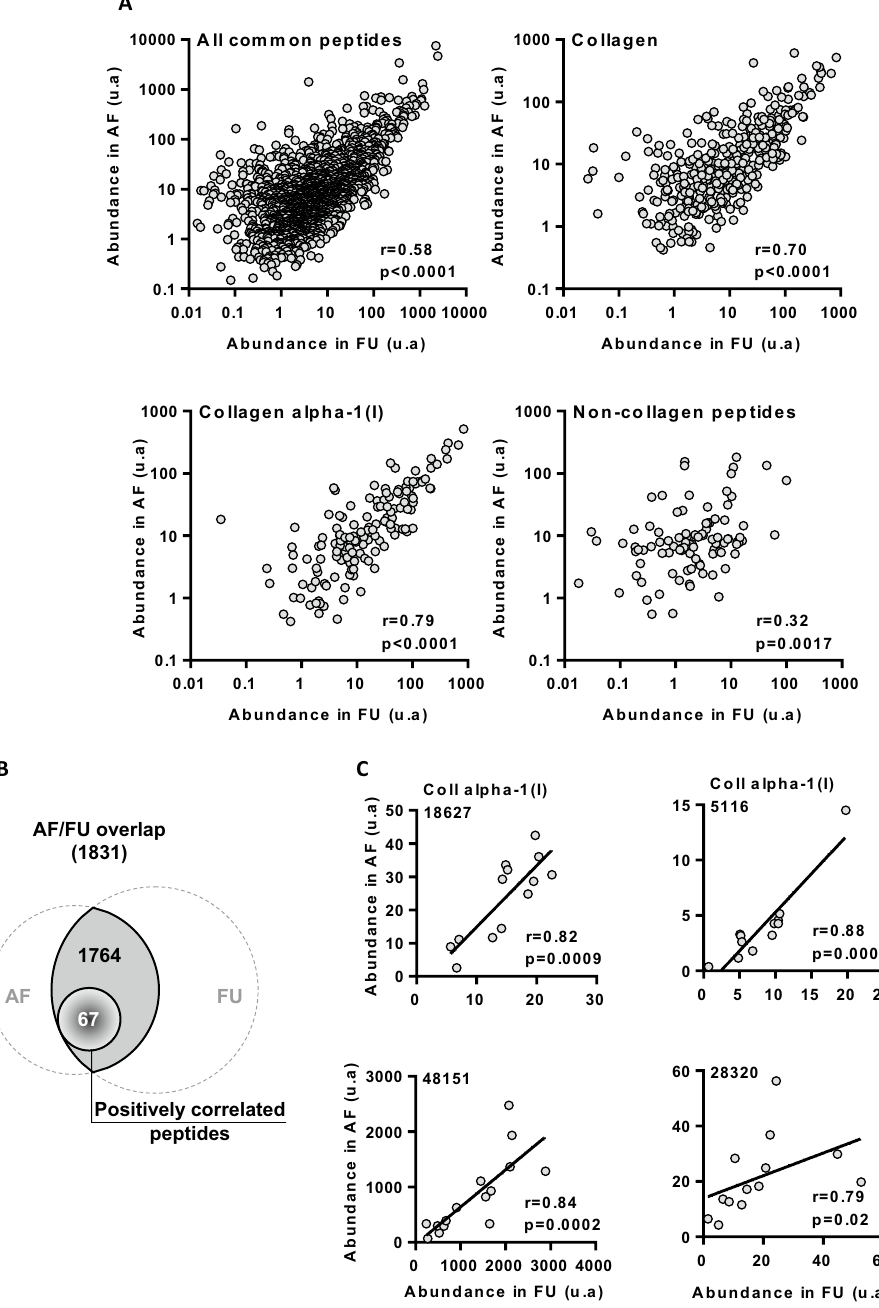
Figure 3. Analysis of matched amniotic fluid and fetal urine samples. ( A ) Correlation of the average abundance in AF of all, collagen, collagen alpha-1(I) and non-collagen overlapping peptides with their average abundance in FU irrespective of gestational age. r, Spearman correlation coefficient. ( B ) Number of common peptides whose abundance is correlated in matched amniotic fluid (AF) and fetal urine (FU) from a subset of 16 fetuses. The total number of peptides in the overlap is indicated in parentheses. ( C ) Correlation between abundance of 4 representative overlapping peptides. r, Spearman correlation coefficient. 18627, fragment of collagen alpha-1(I) chain; 5116, fragment of collagen alpha-1(I) chain; 48151 and 28320, non-sequenced peptides. Coll,